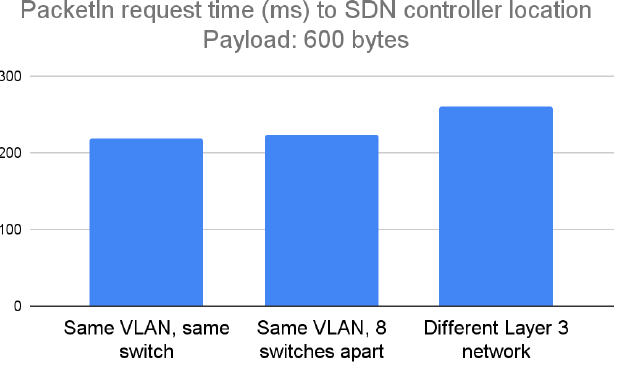
Figure 7. Experimental results of running the design for portability in case of a PacketIn packet with a payload of 600 bytes, considered a small payload.